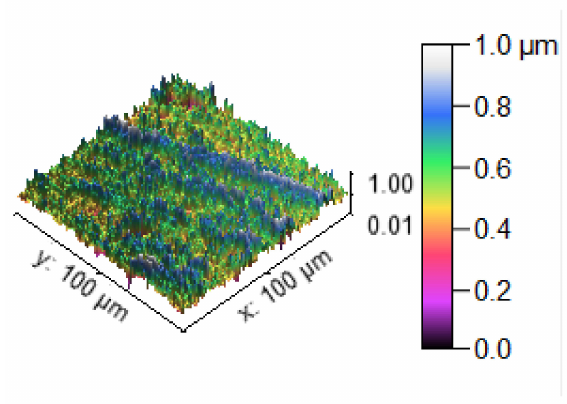
Figure 20. Three dimensional (3D) profilometric image (S-8).